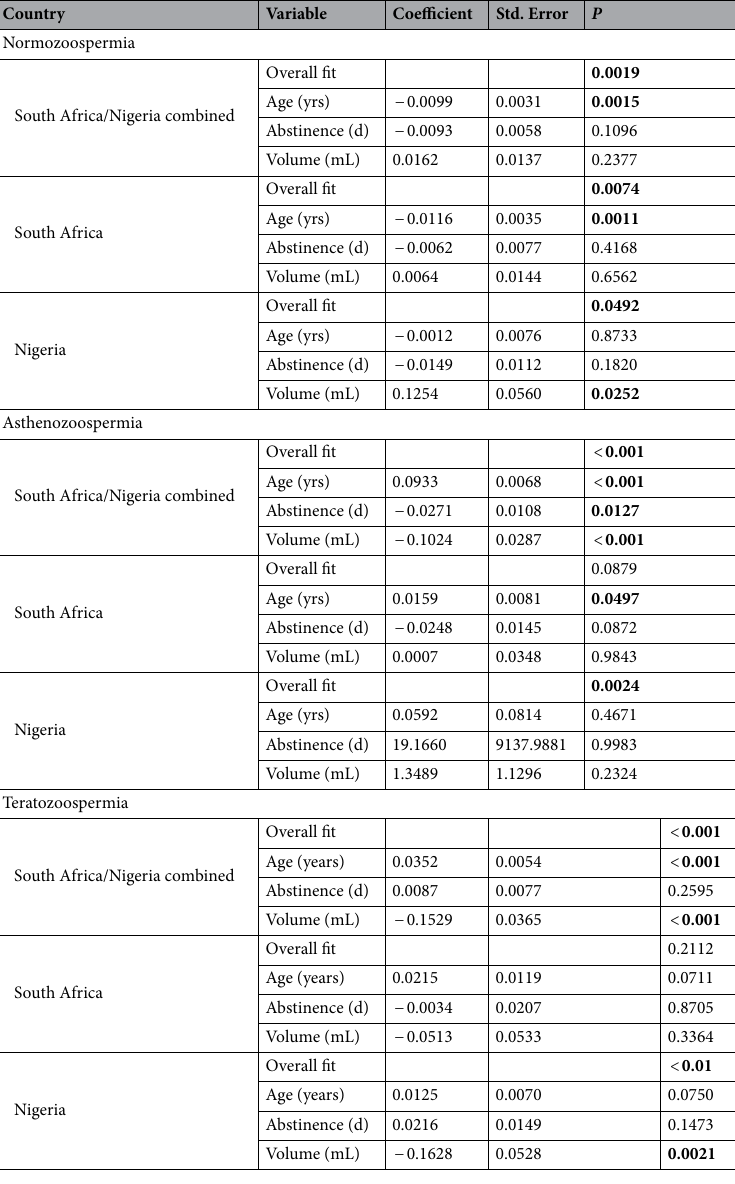
Table 5. Logistic regression analyze the influence of the independent variables age, abstinence and ejaculate volume on the clinically important classifications normozoospermia, asthenozoospermia and teratozoospermia. Significance values are in